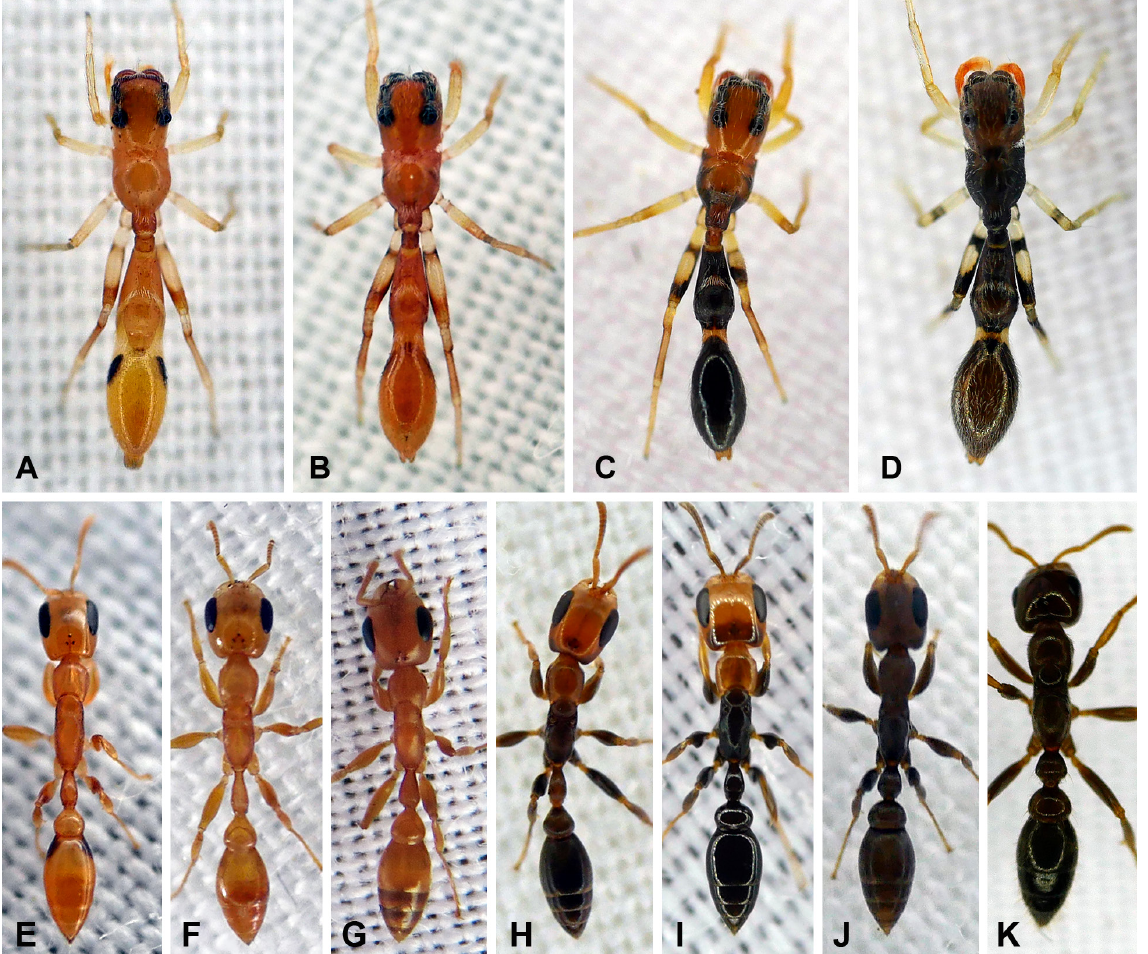
Fig. 9. A–D . Color variants and potential ant models for Synemosyna nicaraguaensis Cutler, 1993. A . Orange female, La Guardia, Santa Cruz Dept. B . Orange male, same location. C . Orange/black male, same location. D . Dark brown male, Villa Teresa, La Paz Dept. E . Pseudomyrmex simplex (Smith, 1877). F . P. cf. pallidus (Smith, 1855). G . Pseudomyrmex sp . H . P. filiformis (Fabricius, 1804). I . P. peruvianus (Wheeler, 1925). J . P . elongatus (Mayr, 1870). K . P . triplarinus (Weddell,